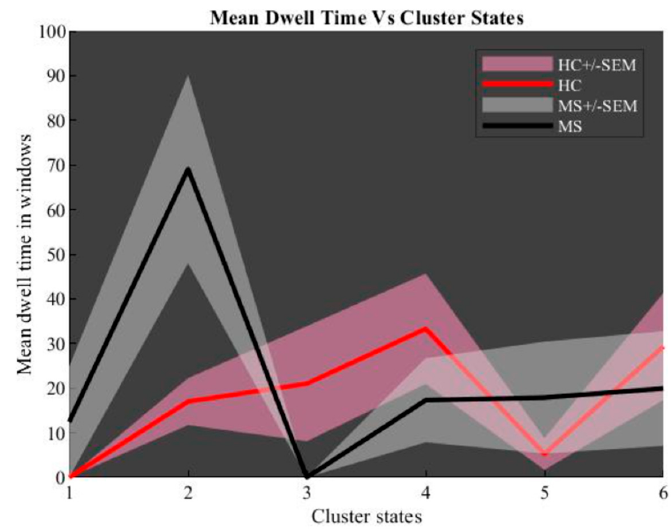
Figure 7. Dynamic connectivity maps: mean dwell time windows vs. cluster states.